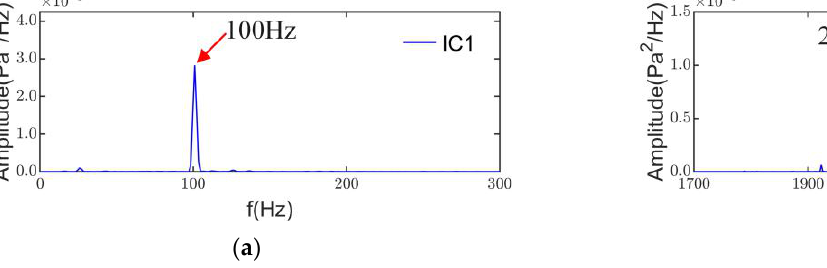
Figure 15. Power spectral density: ( a ) IC1; ( b ) IC2 .